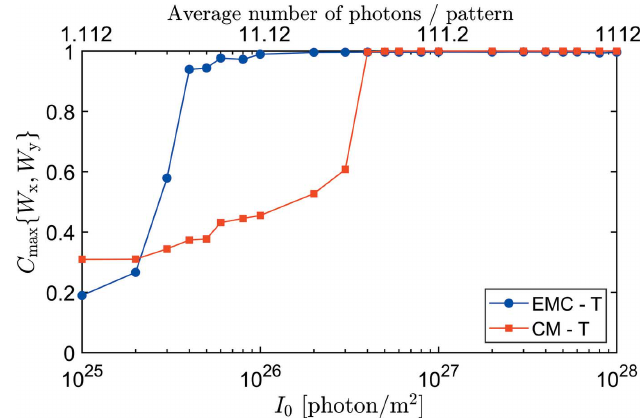
Figure 3 The maximums of Pearson correlation between circular 1D intensity distributions W x and W y as rotated relative to each other, for lysozyme at scattering angle # ¼ 15 (cid:5) and various incident XFEL fluence values. W x denotes the intensity distribution reconstructed by either EMC (blue circles) or CM (red squares). W y refers to the reference intensity distributions W T or W 0 . C max is calculated in all four combinations, but only correlation with W T is plotted, the one with W 0 would overlap almost